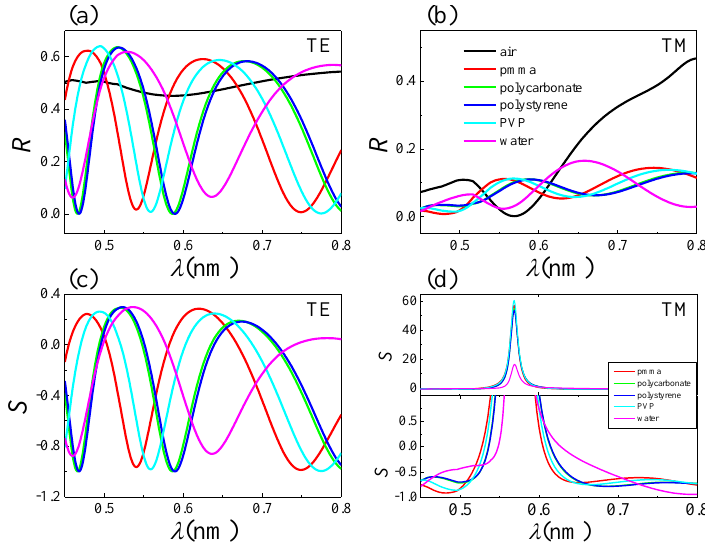
Figure 5. Effect of different media filling the InAs nanowire assembly. Optical response calculated for different media surrounding the NWs, for TE ( a ) and TM ( b ) polarization. The filling media are indicated in ( b ). Sensitivity or relative reflectance variation S = ( R - R air )/ R air for TE ( c ) and TM ( d ) polarizations. The incidence angle is 55 ◦